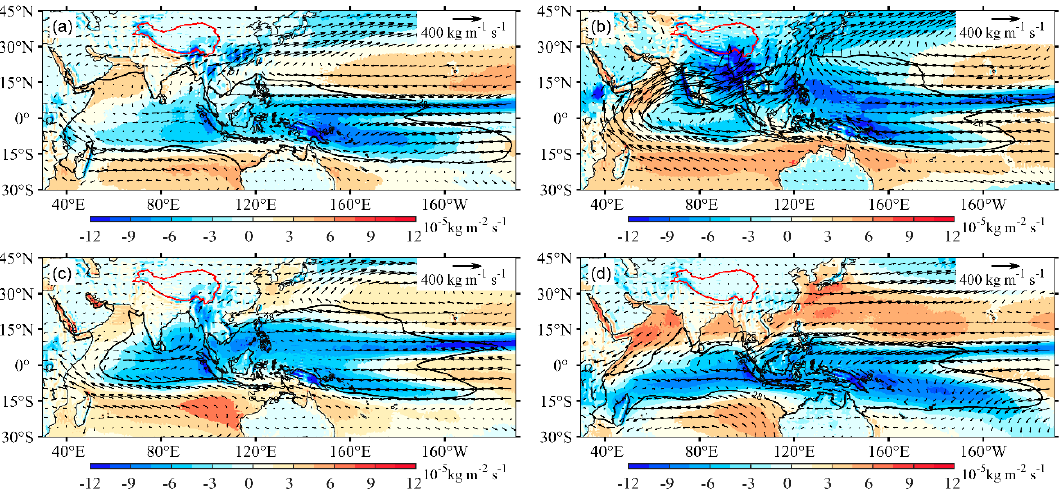
Figure 2. Vertically integrated climate mean seasonal water vapor flux (vectors, unit: kg m − 1 s − 1 ) and divergence (shaded areas, unit: 10 − 5 kg m -2 s − 1 ) ( a ): spring; ( b ): summer; ( c ): winter and ( d ): autumn) of years ranging from 1979 to 2018 for the TP and IPWP (red and black lines, respectively).